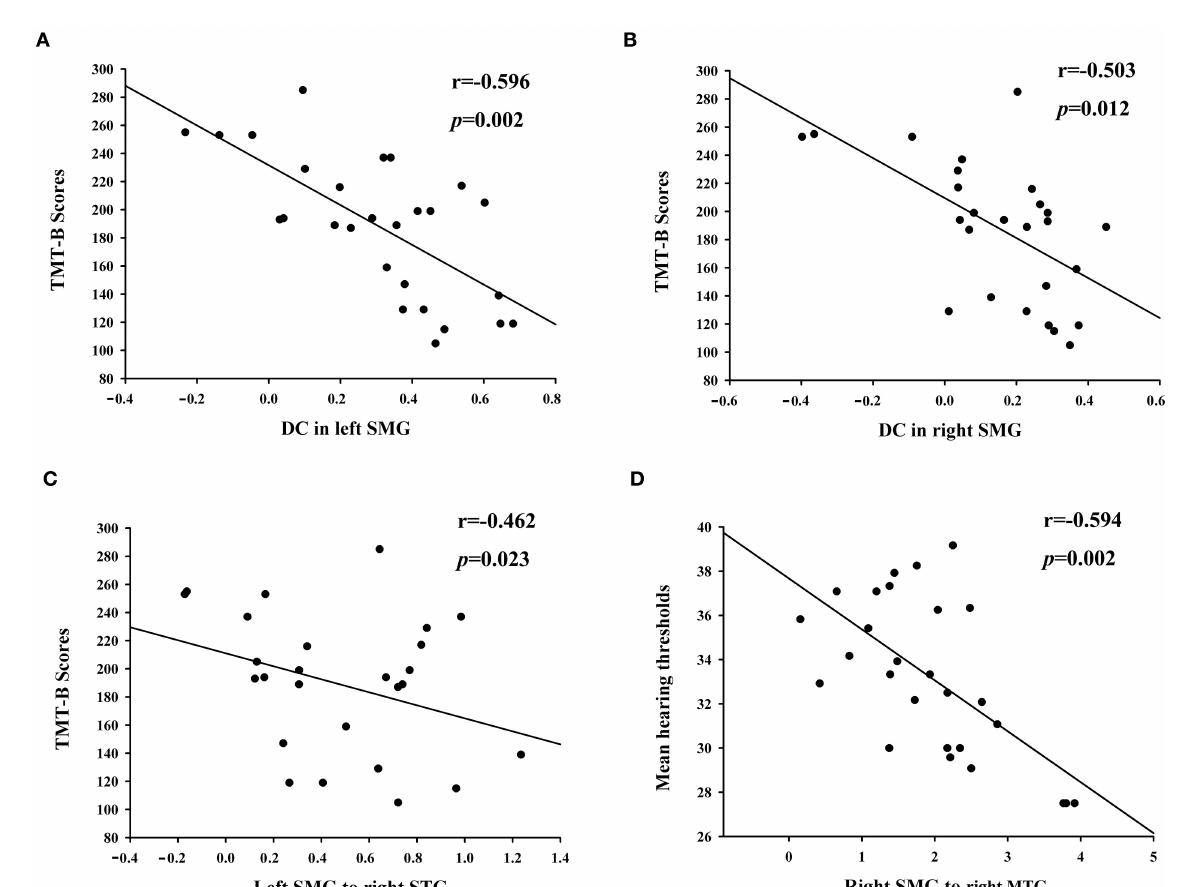
FIGURE3 Correlation between altered brain functional network and clinical characteristics in patients with ARHL. The reduced DC in left and right SMG showed significant negative correlations with poorer TMT-B scores (A,B) . The TMT-B scores were negatively associated with left SMG connectivity to right STG (C) . The right SMG connectivity to right MTG was negatively correlated with the mean hearing thresholds (D)